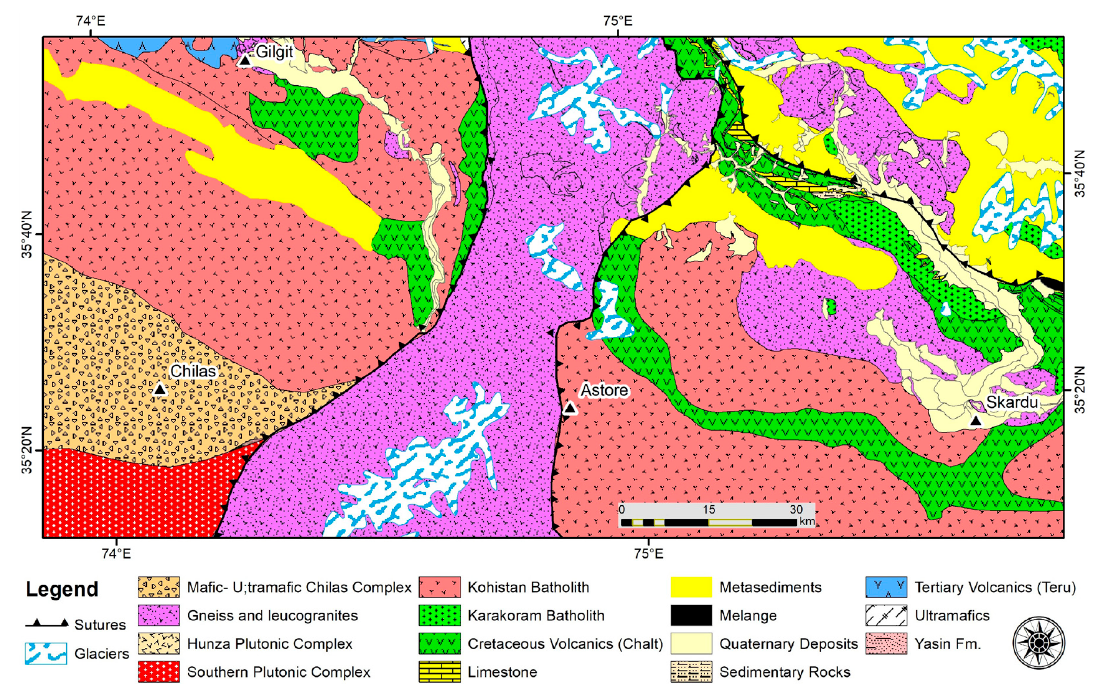
Figure 2. Geologic map of the Astor area in Northern Pakistan. Bulk samples were collected from the Astore area. Modified from [35].